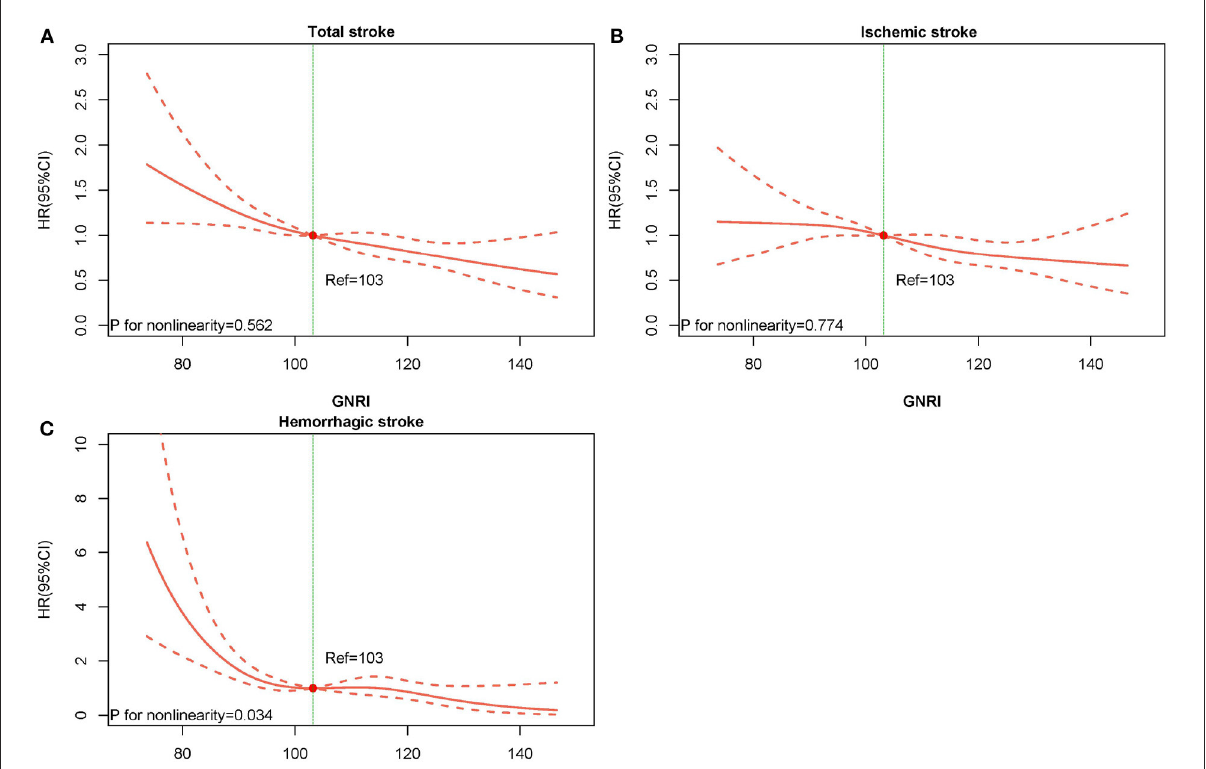
FIGURE4 Dose-response association between GNRI and risk of stroke events. (A) Total stroke, (B) ischemic stroke, and (C) hemorrhagic